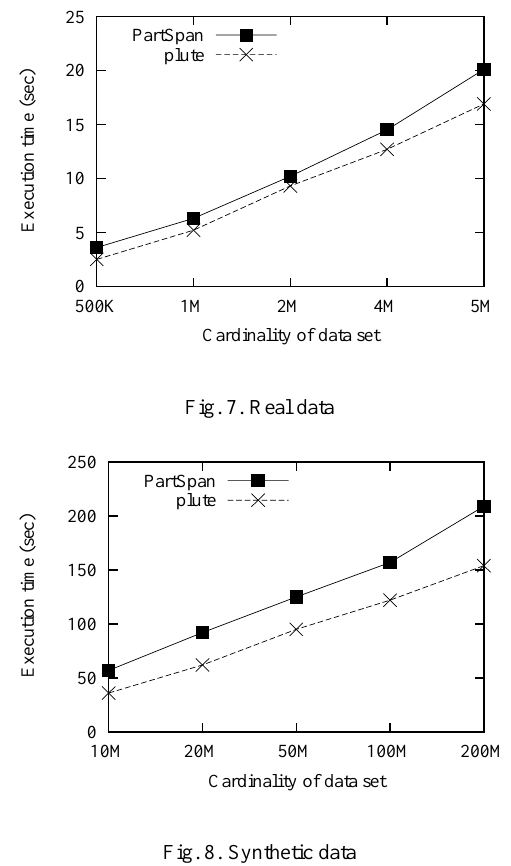
Fig. 8. Synthetic data